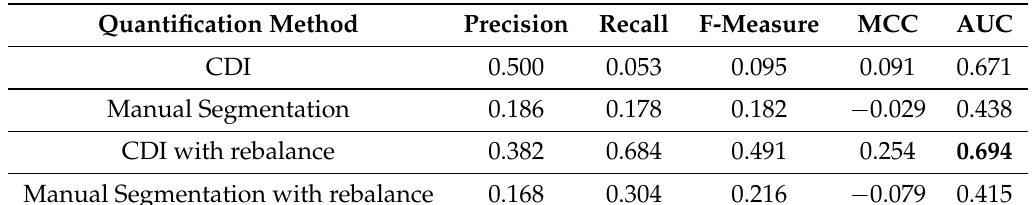
Table 6. Prediction performance of ANN using three top CDI locations and manual segmentation on X3 slice.